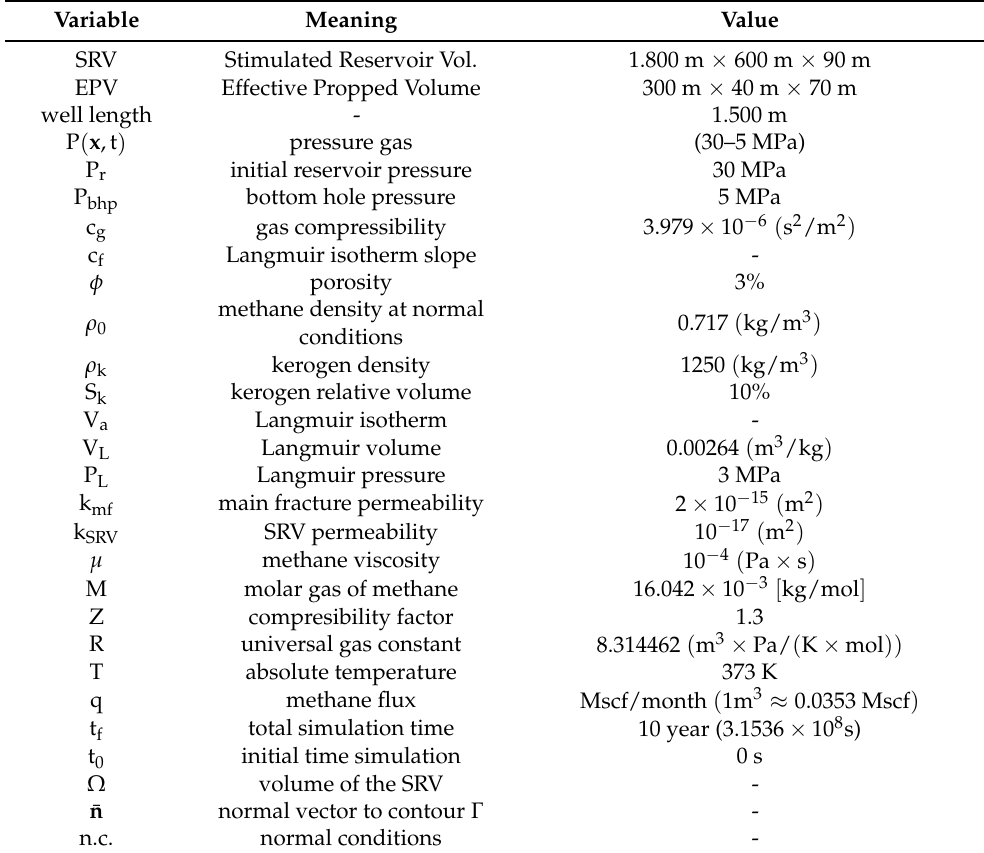
Table 2. Variables and